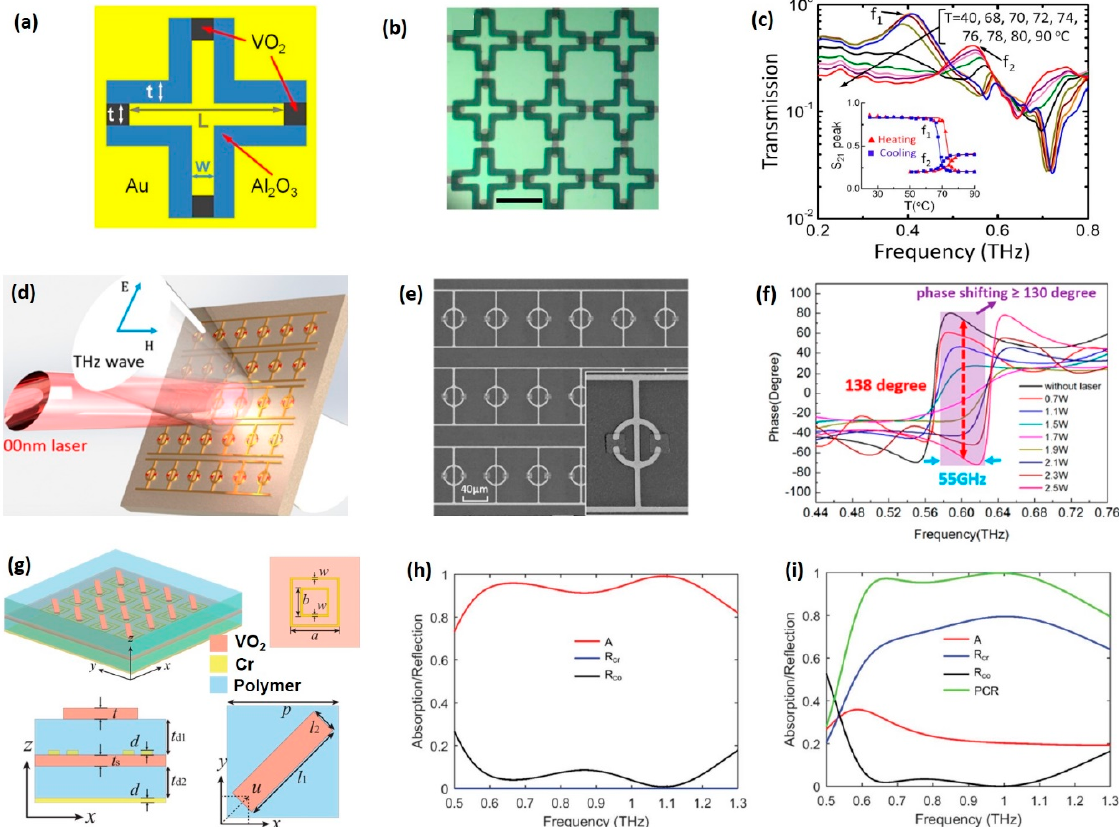
Figure 13. Metal VO 2 hybrid metamaterials. ( a ) Schematic view of a single loop cross dipole (LCP) unit and ( b ) the optical microscope image (scale bar corresponds to 100 um). ( c ) Measured S 21 coefficients of the LCP as a function of temperature during the heating process. The inset shows f 1 and f 2 peak positions versus temperature in heating and cooling cycles. Reproduced from [30], with permission from Optical Society of America 2013. ( d ) Schematic of the photoinduced phase converter fabricated by VO 2 hybrid photoconductive composite structure (PCS) and ( e ) the SEM images of the device. ( f ) The phase diagram of the PCS triggered by different laser fluence. Reproduced from [26], with permission from American Chemical Society 2018. ( g ) Schematic of a VO 2 -integrated THz device with switchable functionalities. The dimensions in the side and top view are p = 100 um, l 1 = 110 um, l 2 = 26 um, t = t s = 1 um, td 1 = 40 um, td 2 = 34 um, a = 55 um, b = 36 um, w = 1 um and d = 0.3 um, respectively. ( h ) Simulated absorption, copolarized reflection and cross-polarized reflection at normal incidence when VO 2 is in the insulating state with σ = 200 S/m. A , R co , R cr and PCR represent the absorption, cross-polarized reflection, copolarized transmission and polarization conversion of the device, respectively. ( i ) Simulated absorption, copolarized reflection, cross-polarized reflection, and PCR at normal incidence when VO 2 is in its fully metallic state with σ = 200,000 S/m. Reproduced from [25], with permission from WILEY-VCH 2018.